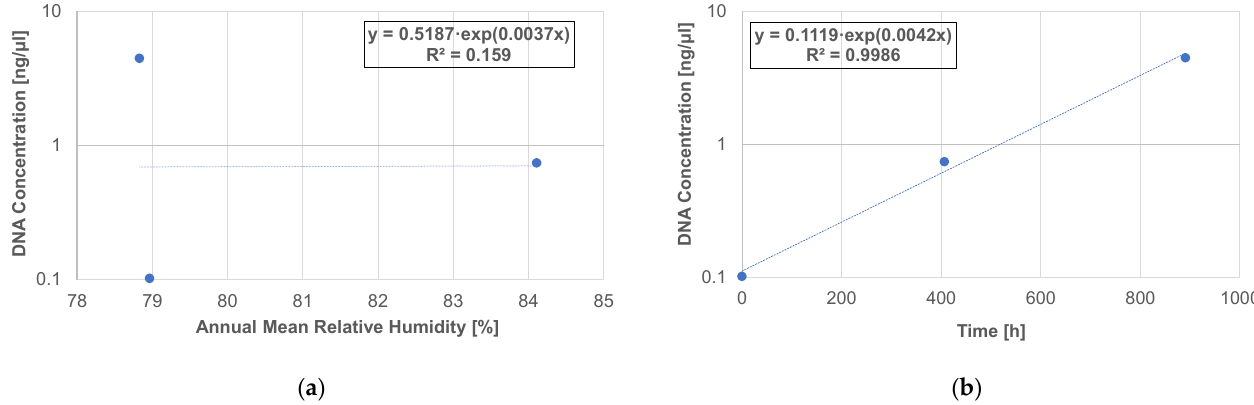
Figure 8. Correlation between the DNA concentrations of microorganisms and relative humidity on the west side of the thatched roof. The horizontal axis represents the ( a ) annual mean relative humidity and ( b ) total hours when the relative humidity reached 100%. The samples were collected from three locations (under side of the eaves, roof surface side, and inner side of roof), and the relative humidity of outdoor air, roof surface 1, and 250 mm inside the roof were adapted.